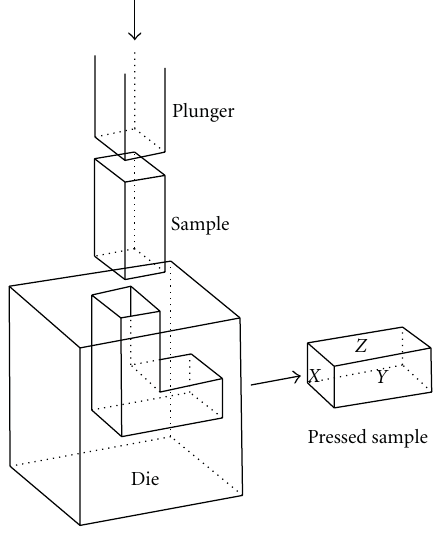
Figure 1: Schematic diagram of